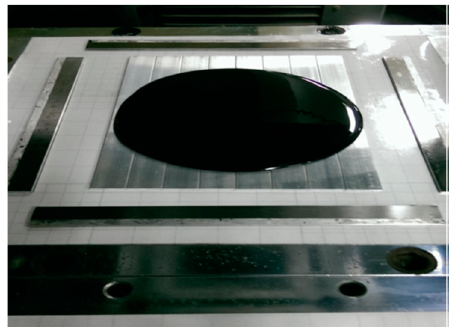
Figure 1. Multi-walled carbon nanotube (MWCNT)/epoxy mixture placed on the aluminum (Al) substrate.